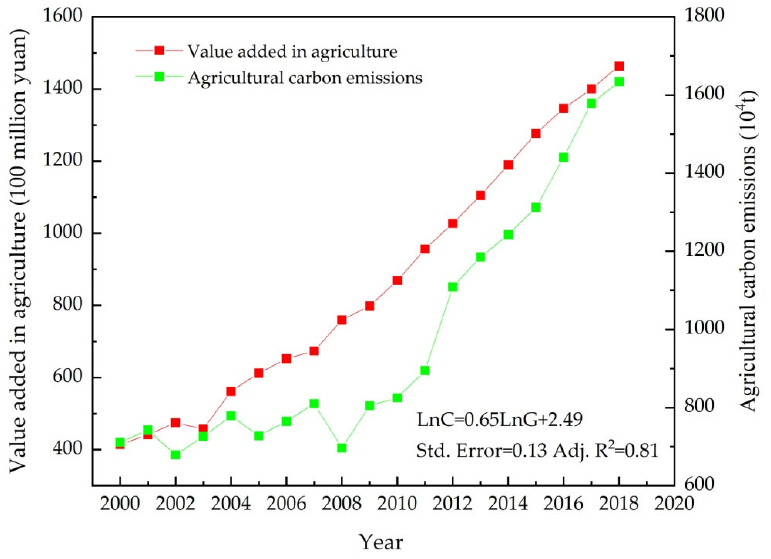
Figure 3. Value added in agriculture and agricultural carbon emissions in Heilongjiang province (2000–2018).